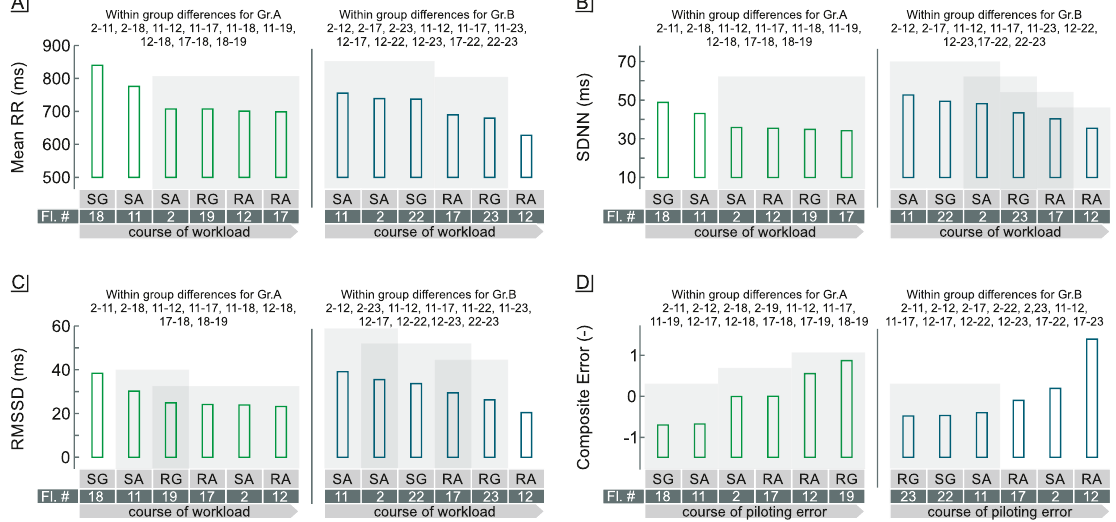
Figure 4. Mean RR ( A ), SDNN ( B ), RMSSD ( C ) and composite Error ( D ) results of pairwise comparison for subjects with no additional training for glass-cockpit (Gr. A) and subjects with additional training (Gr. B). The results are complemented with the workload and piloting error course with respect to specific measured flight, where non-significant differences between respective measuremets are highlighted. (S—simulated flight, R—real flight, A—analog cockpit, G—glass cockpit, Fl. #—flight